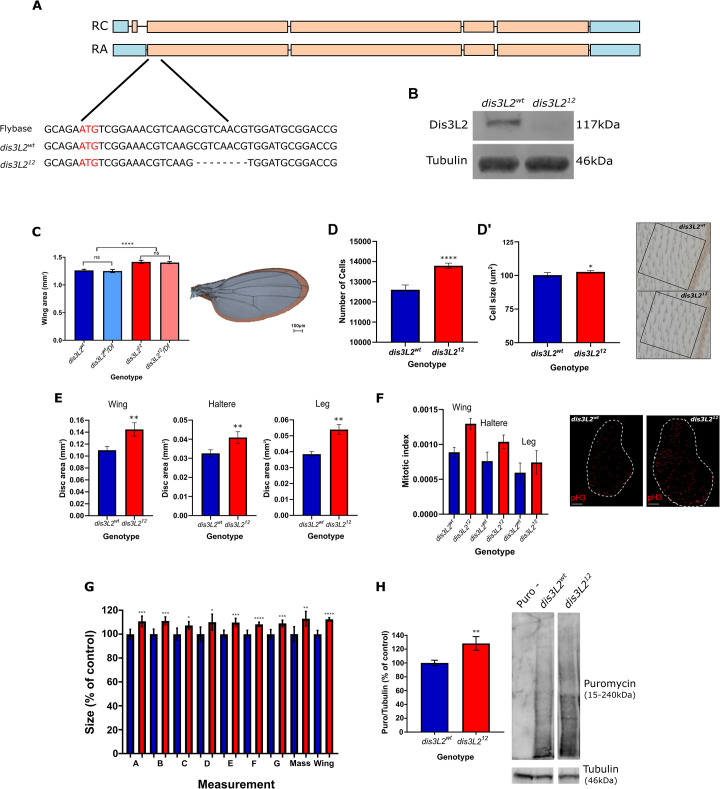
dis3L212 mutants show overgrowth phenotypes.A) Schematic showing location and details of the dis3L212 mutation. Coding exons are marked in orange and 5’ and 3’ UTRs in blue. RC and RA denote the two dis3L2 isoforms and red letters denote the start codon. B) The 8bp mutation in dis3L212 flies results in a complete absence of the Dis3L2 protein. C)
dis3L212 wings (red) are significantly larger (14%) than control dis3L2wt wings (blue). Hemizygous dis3L212/Df wings are not significantly different from dis3L212 wings demonstrating that it is a null mutation. n = 16–19, error bars represent 95% CI, **** = p<0.0001, ns = p>0.05, scale bar = 100μm. D/D’) The increased wing area is mainly driven by an increase (12%) in cell number (D) and a small (2%) increase in cell size (D’). n = 13, error bars represent 95% CI, * = p<0.05, **** = p<0.0001. Representative images of one of 5 wing locations used to calculate wing area is shown for dis3L2wt and dis3L212 wings. Each cell is marked by a trichome (hair) in the upper and lower cell layer. E)
dis3L212 wing, haltere and leg imaginal discs are significantly larger (25%, 30%, 36% respectively) than their control counterparts. n = 8–33, error bars represent 95% CI, ** = p<0.01. F) Consistent with an increase in wing area, PH3 staining of wing, haltere and leg imaginal discs demonstrates an increased number of proliferating cells in dis3L212 tissues. n = 5–16, error bars represent 95% CI, scale bar = 50μm. G)
dis3L212 mutants are significantly larger than dis3L2wt flies. Calculated using measurements of various regions of the adult fly (A-G, S7 Fig) and total mass. n = 15–21, error bars represent 95% CI, * = p<0.05, ** = p<0.01, *** = p<0.001, **** = p<0.0001. H) SUnSET labelling performed on wing imaginal disc samples shows increased global translation in dis3L212 discs compared to dis3L2wt. Representative lanes from the same blot are shown along with Tubulin loading control used for quantification. Puro–represents a disc sample incubated in media only without Puromycin. n = 8–14, error bars represent 95% CI, ** = p = 0.0057.